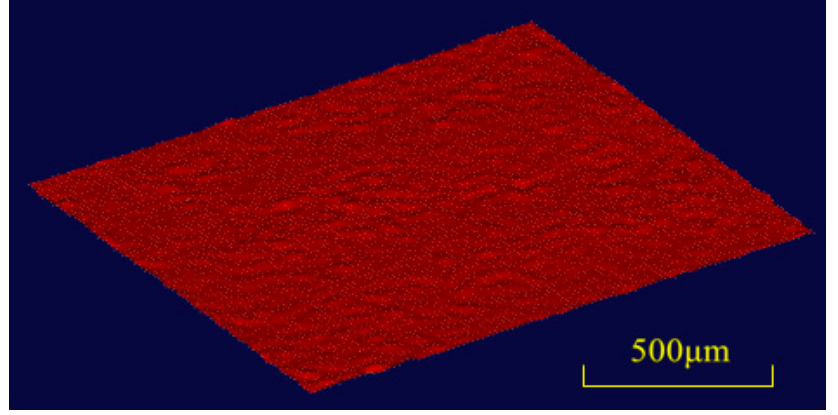
Figure 5. Reconstructed seal end surface morphology.